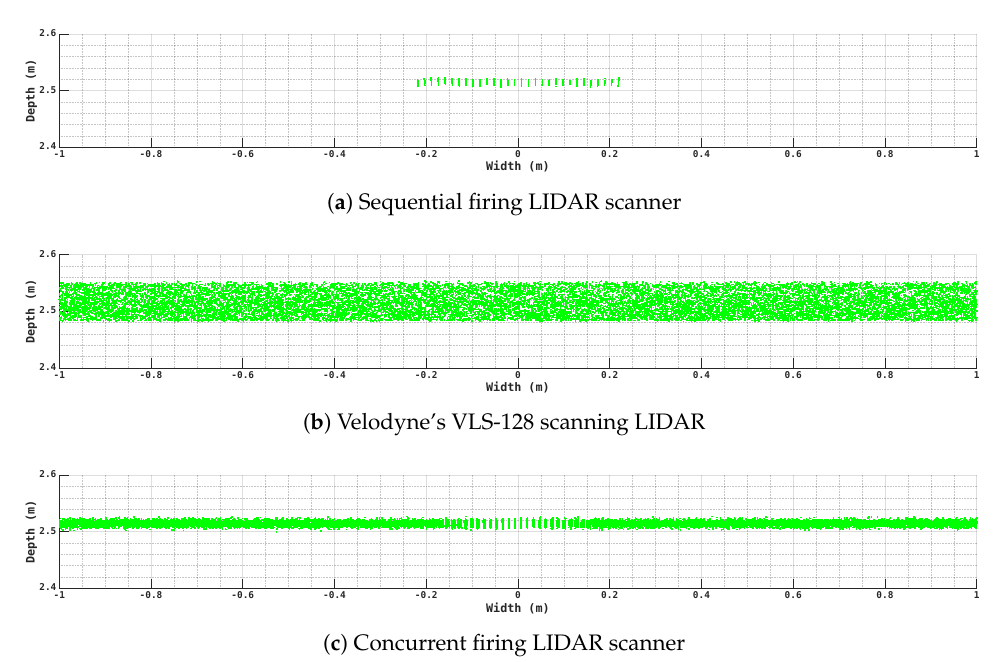
Figure 13. Top view of the maximum detectable range from the three LIDAR